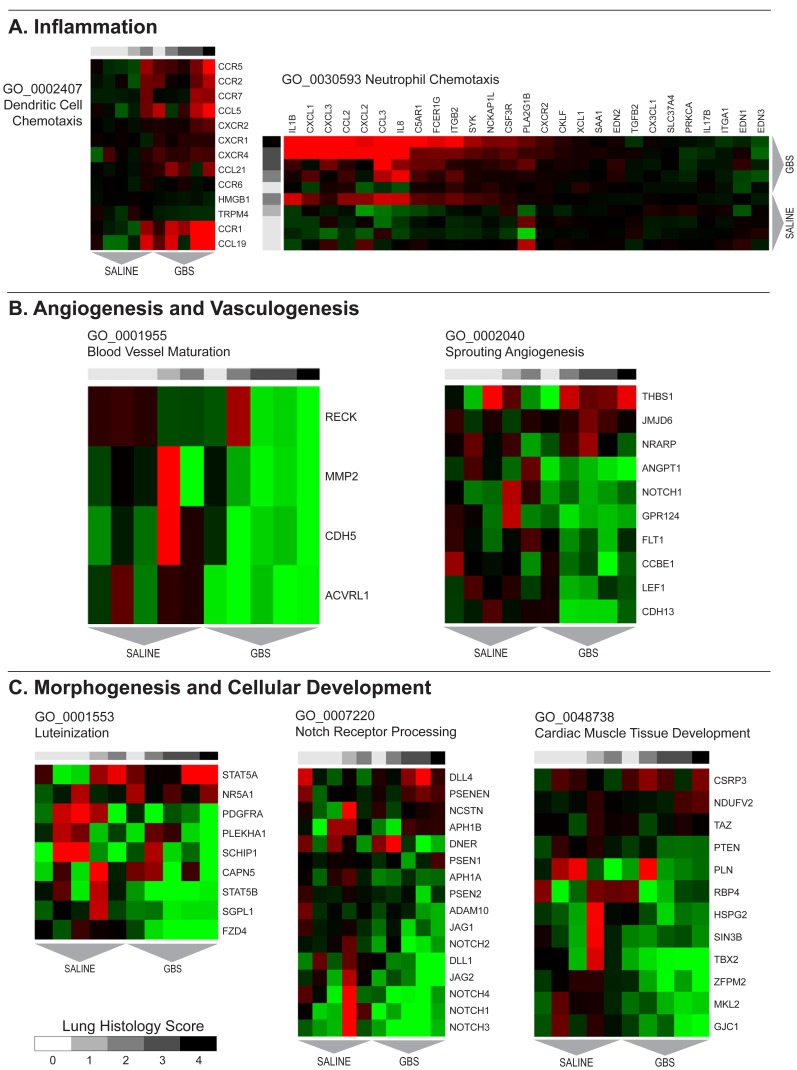
Heatmaps of Gene Ontology gene sets associated with A) inflammation, B) angiogenesis and vasculogenesis, and C) morphogenesis and cellular development pathways.